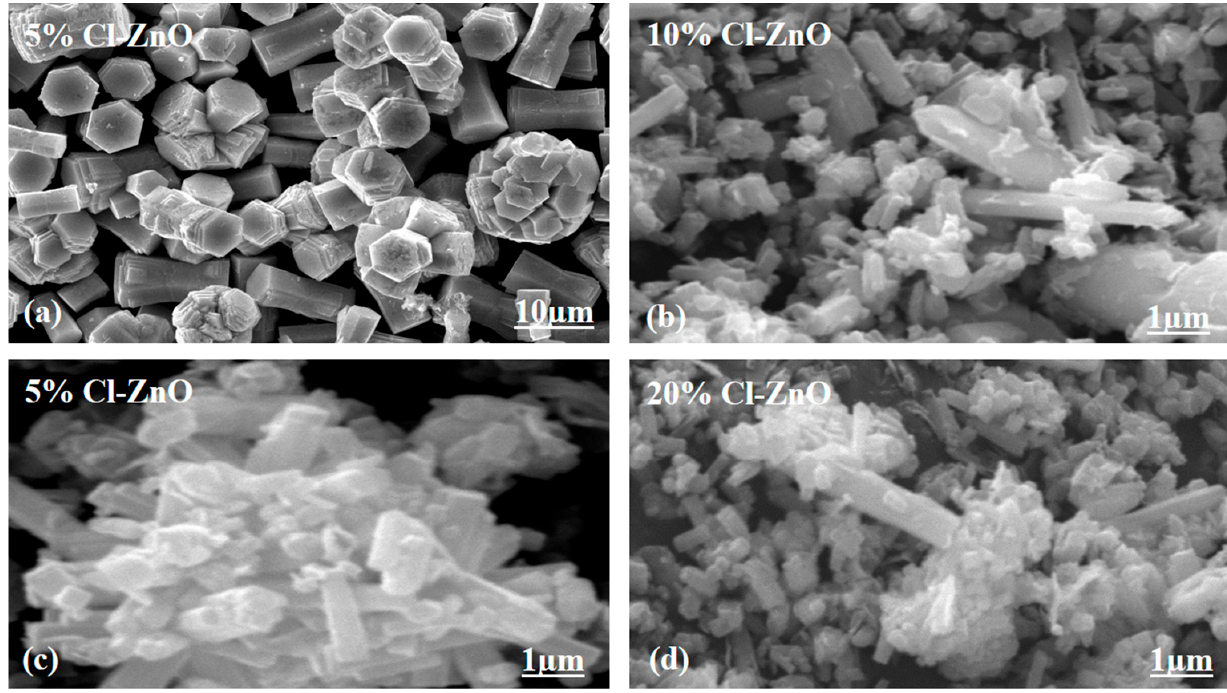
Figure 2. ( a – d ) The 5%, 10%, 15% and 15% Cl − -doped ZnO, respectively.